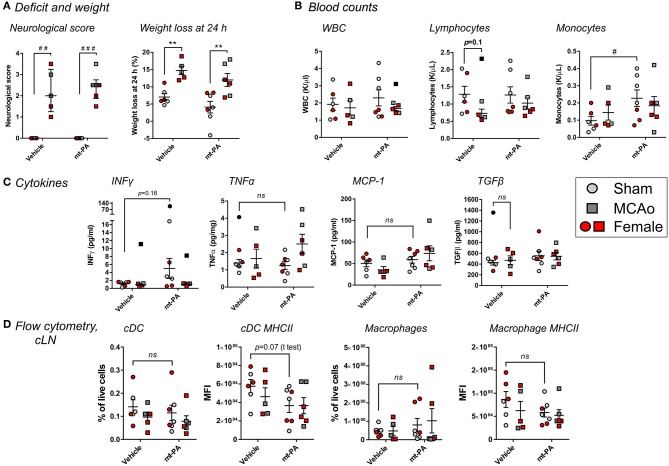
t-PA interactions with immune cells during stroke have a plasmin-dependent component. Effects of mouse t-PA (mt-PA; 0.9 mg/kg) or its HEPES vehicle on various functional and immunological parameters in plasminogen-knockout (plg−/−) mice 23 h after sham surgery or transient MCAo (1 h). (A) In plg−/− mice, t-PA does not exacerbate neurological scores and weight loss, contrary to the observation in wild-type mice (Figure 1). (B) In contrast to blood profiles of C57Bl/6 mice after stroke (Figure 3), no t-PA potentiation of leukopenia and lypmhopenia, and monocytosis instead of monocytopenia, are observed in plg−/− mice. (C) t-PA-induced changes of plasma cytokines seen in wild-type mice (Figure 4) are either reversed (INFγ ↑ instead of ↓) or diminish (no upregulation of TNFα and MCP-1, and no downregulation of TGFβ) in plg−/− mice. (D) Finally, no t-PA-mediated reductions in cDC and macrophages and altered profiles of MHC II expression are observed in the cervical lymph nodes (cLN) of plg−/− mice, in contrast to C57Bl/6 wild-type mice (Figure 5). Taken together, plasminogen mediates many of the t-PA effects on immune cells during stroke. Data is shown as individual animals (gray for male and red for female mice) with mean ± SEM. n = 6 for sham vehicle, 7 for sham mt-PA, 5 for MCAo vehicle, 6 for MCAo mt-PA. **p < 0.01 by two-ANOVA with Sidak's post-hoc, #p < 0.05, ##p < 0.01, ###p < 0.0001 by the Mann–Whitney U-test (A) or by the student t-test (B). Outliers are denoted in black symbols and excluded from the analysis.